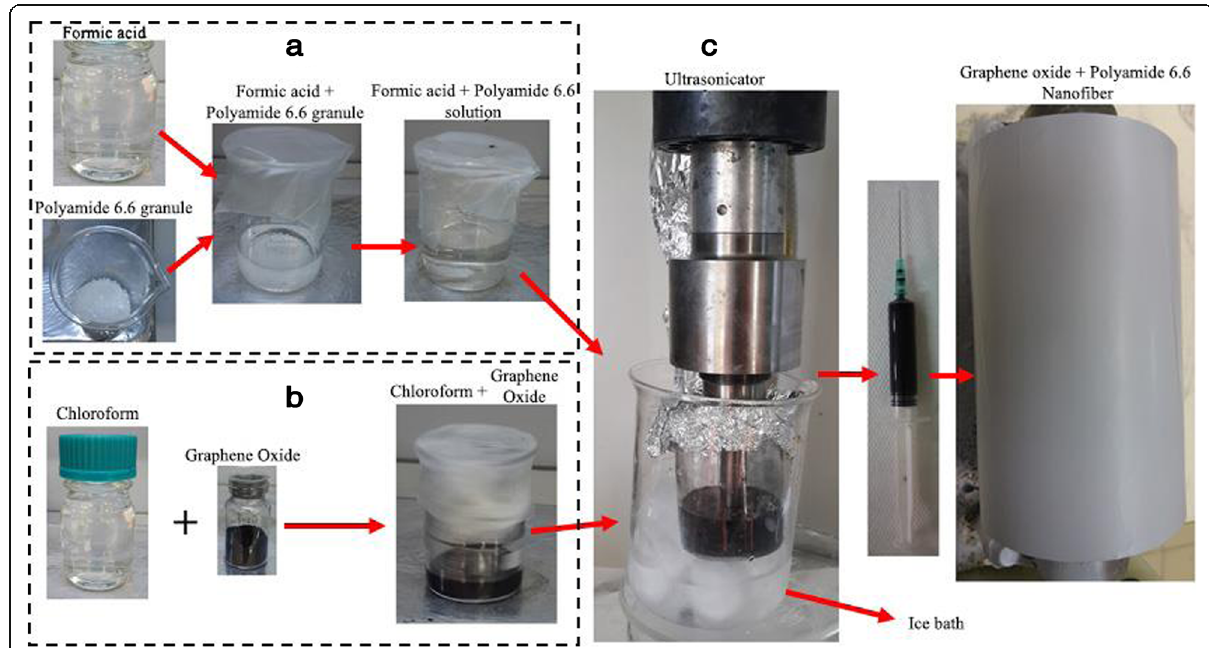
Fig. 3 a Solving N6,6 in formic acid. b Distribution of GNP in chloroforms. c Preparation of N6,6/GO nanocomposite